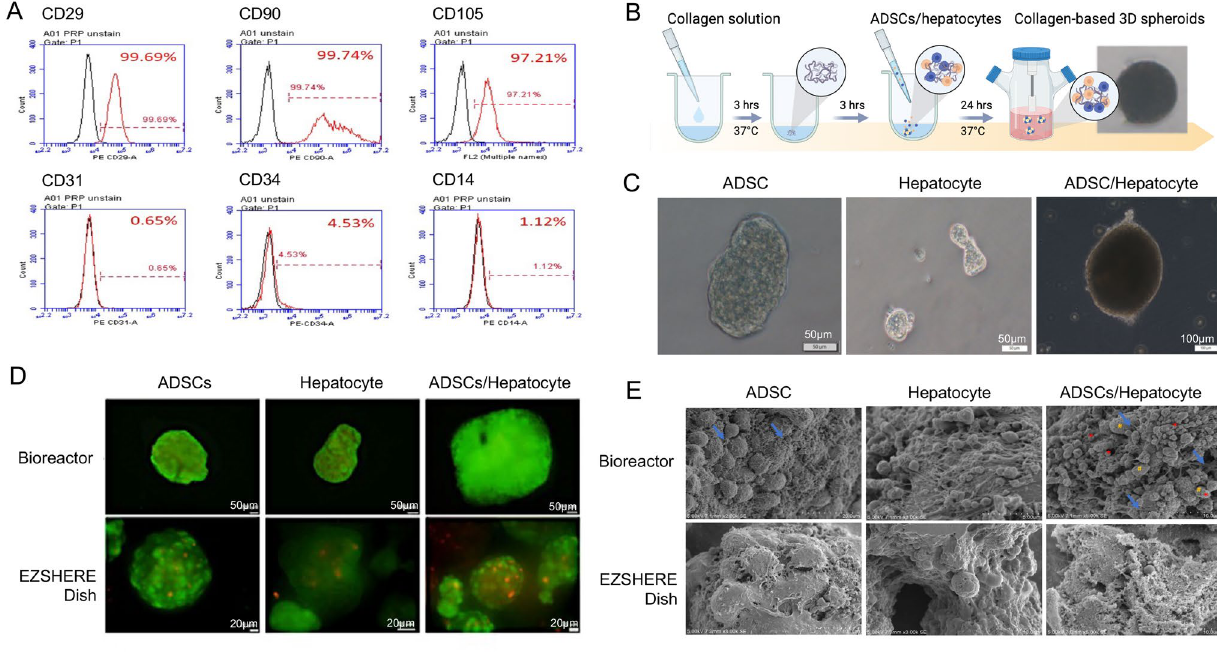
Figure 1. ( A ) Expression of CD29, CD90, CD105, CD31, CD34, and CD14 in isolated adipose-derived stem cells (ADSCs). ( B ) Schematic of the production of cell spheroids. ( C ) The produced spheroids in the bioreactor (after 24 h culture). Scale bar: 50 or 100 μm. Created with BioRender.com. ( D ) Live/dead fluorescence assay of spheroids. Green: calcein-AM and red: EthD-1. Scale bar: 50 μm (top panels) and 20 μm (bottom panels). ( E )